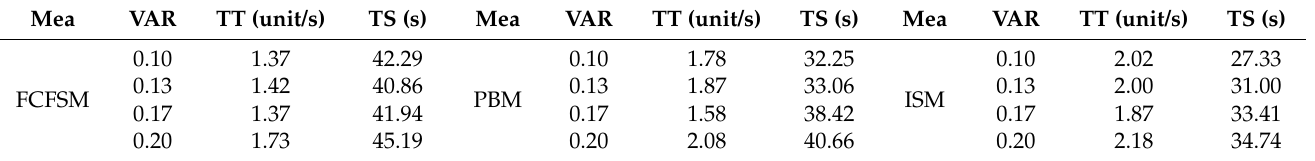
Table 2. Comparision of FCFSM, PBM, and ISM under different